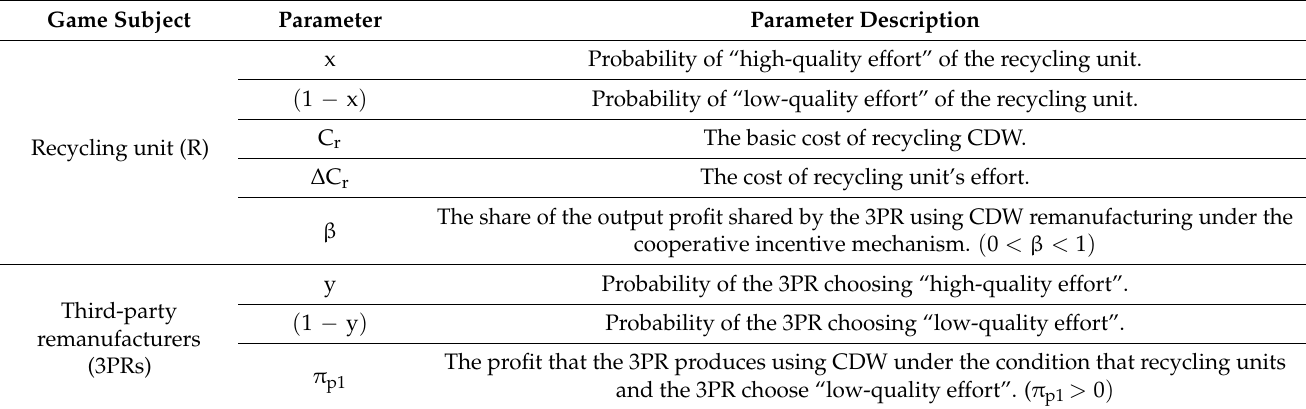
Table 4. Related parameters and description of the main body of the game in the second